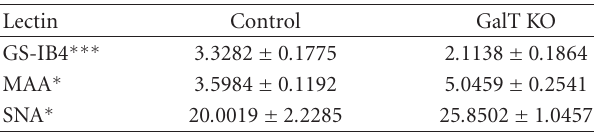
Table 2: Signal intensities of enzyme-linked lectinosorbent assays